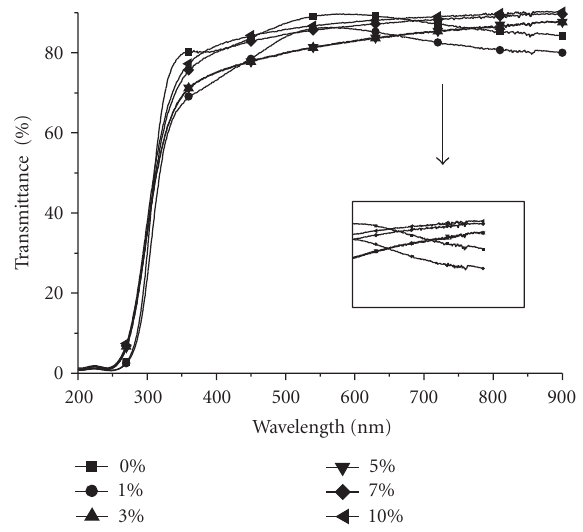
Figure 5: The transmittance of SnO 2 films deposited at various oxygen pressure